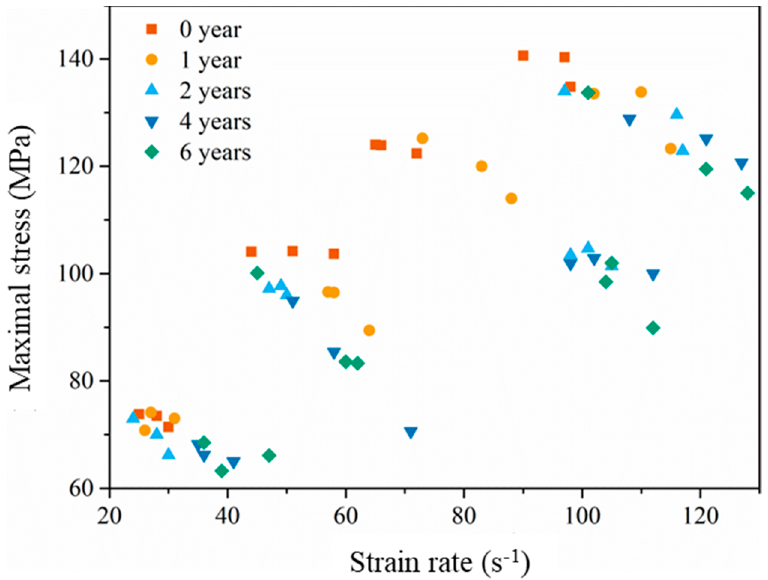
Figure 13. The scatter of the maximal compression stress with different strain rate. Dynamic increase factor (DIF) is introduced to characterize the increase of the maximal compression stress with the increase of strain rate.